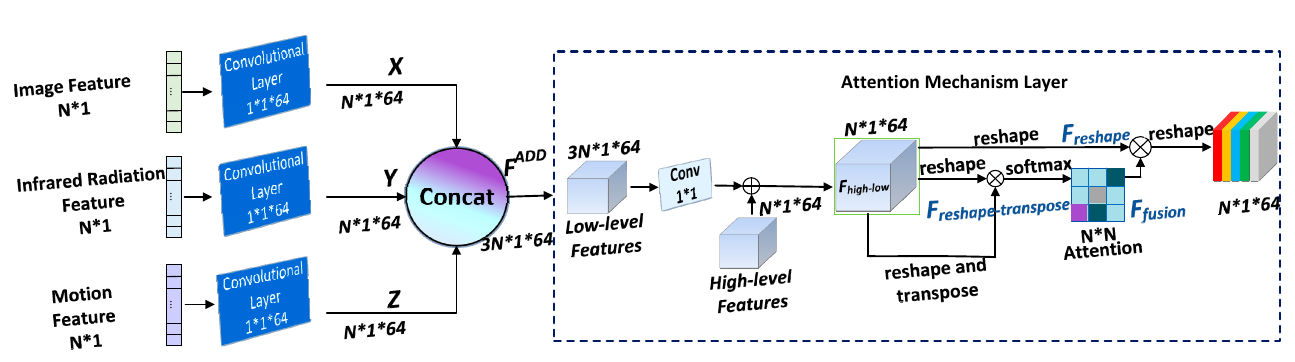
Figure 11. Schematic diagram of the architecture of the MFFN.